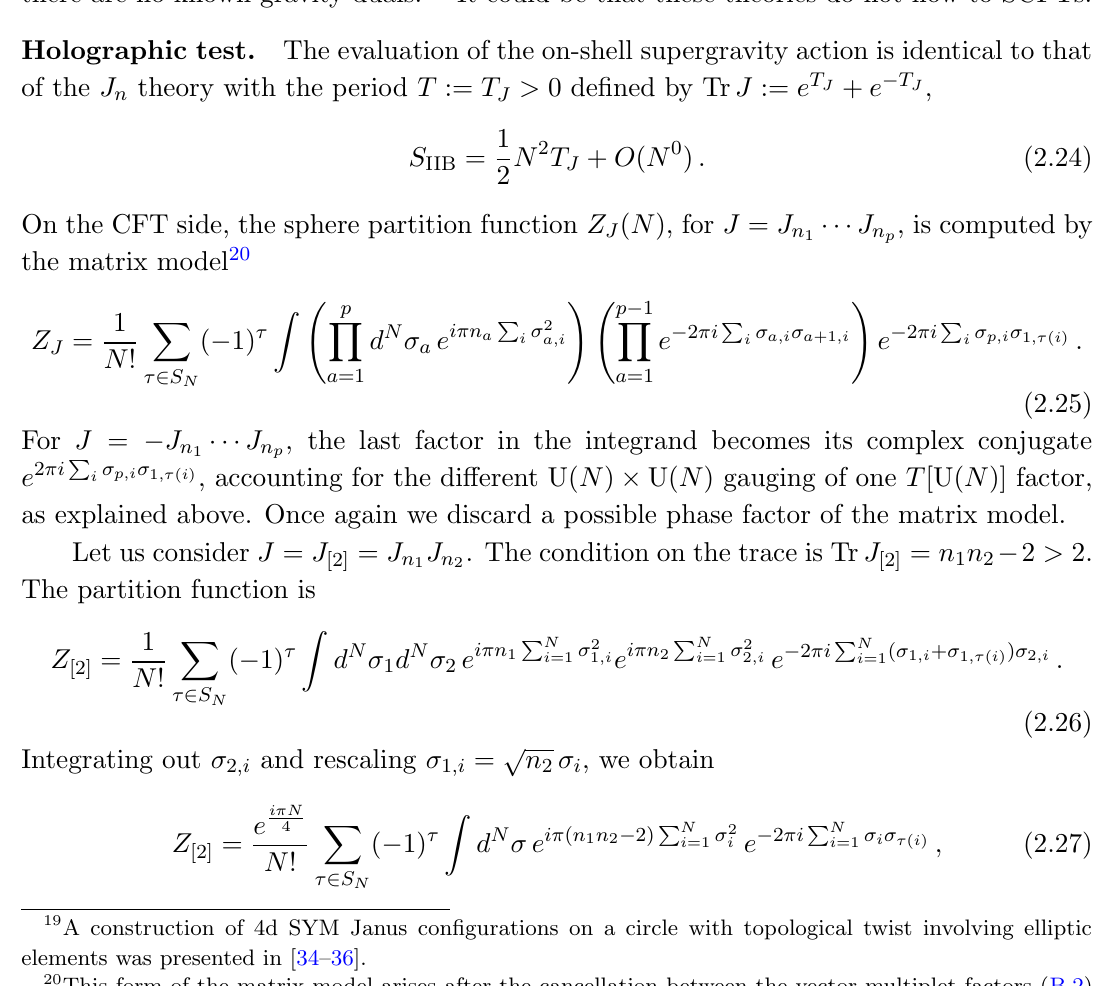
Figure 3 . Quiver description of a J theory, with J = J n Subscripts of gauge nodes indicate Chern-Simons